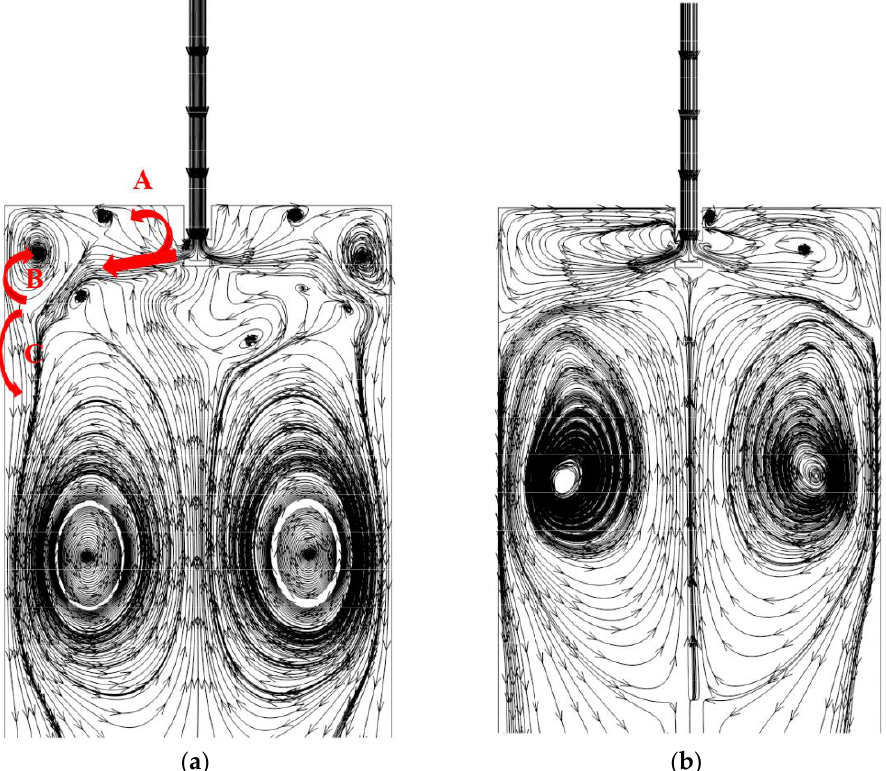
Figure 7. Streamlines on the mold center plane at different casting speeds of ( a ) 1.1 m/min, ( b ) 1.2 m/min.